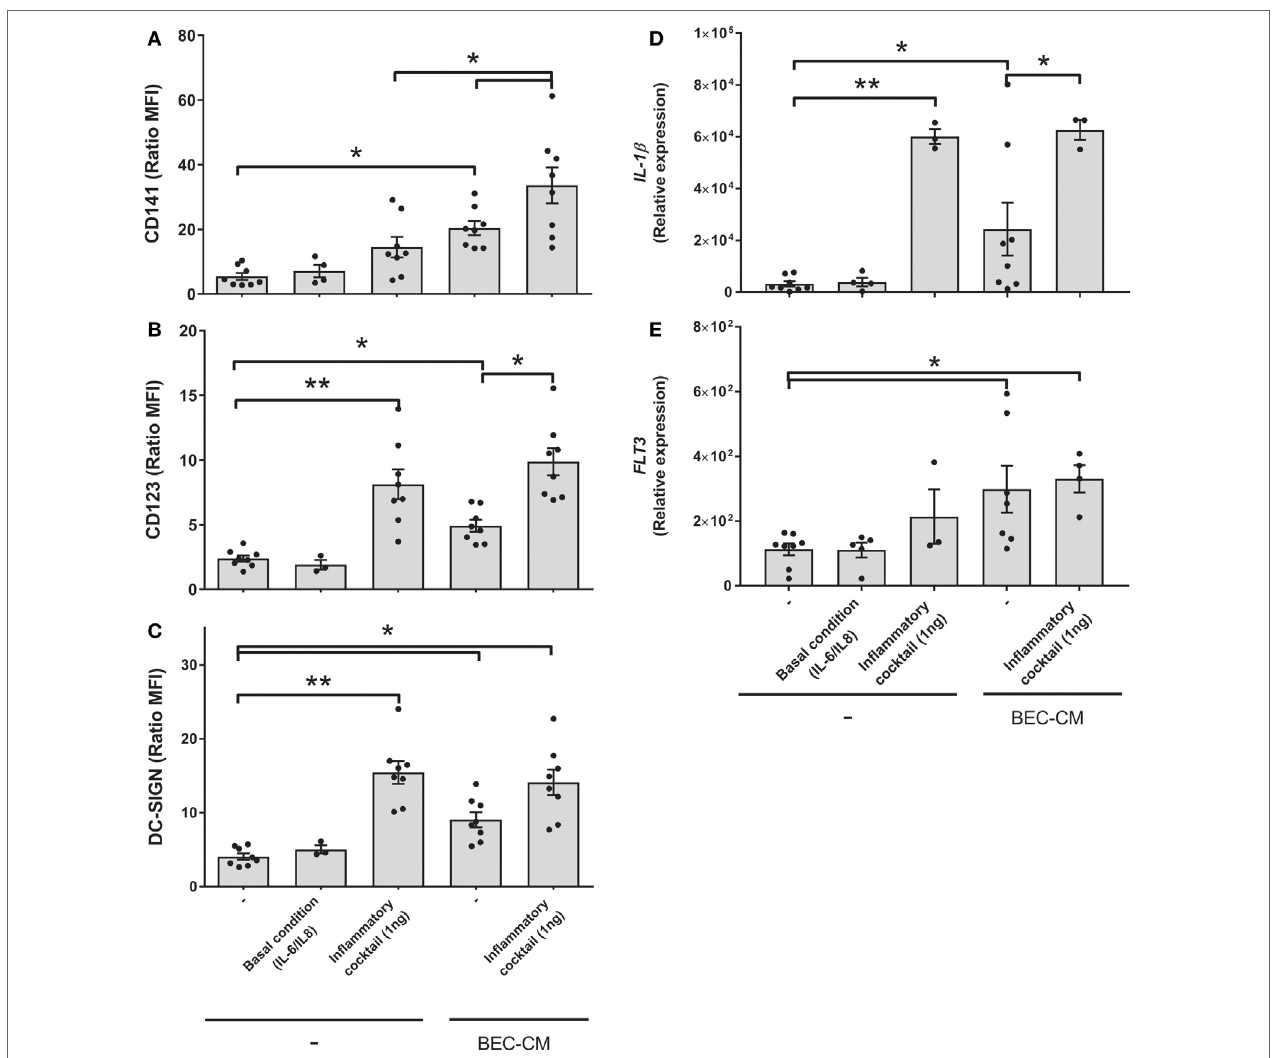
FigUre 7 | inflammatory cytokines boosted the expression of cD141 in monocytes cultured in bronchial epithelial cell-conditioned media (Bec-cM) . Monocytes were cultured for 48 h (a–c) or 24 h (D,e) with medium alone or with BEC-CM. Cells were supplemented with IL-6 (100 pg/mL) and IL-8 (500 pg/mL) designated as the basal condition or with 1 ng/mL of the following cytokines: IL-6, IL-8, IL-15, IL-1 β , GM-CSF, and TNF- α , designated as the inflammatory cocktail. The mean fluorescence intensity ratio calculated with its specific isotype for the expression of (a) CD141, (B) CD123, and (c) DC-SIGN is plotted. Data are expressed as means ± SEM of eight independent experiments (* P < 0.05). Statistical analysis was performed using analysis of variance test (ANOVA) (followed by Tukey multiple comparisons test). Gene expression of (D) IL-1 β and (e) FLT3 were assessed by real-time quantitative PCR. Data express the relative gene abundance normalized to the endogenous control β -2-microglobulin (B2M) and are shown as mean ± SEM of three to six independent experiments, performed in duplicate. Statistical analysis was performed using ANOVA (followed by Tukey multiple comparisons test) (* P < 0.05, ** P <